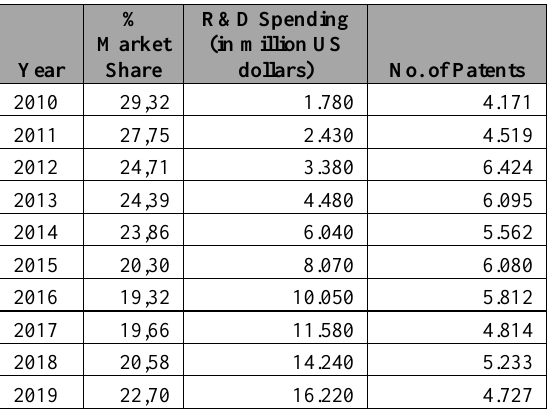
Table 12: Apple Ten Years Data (2010-2019)